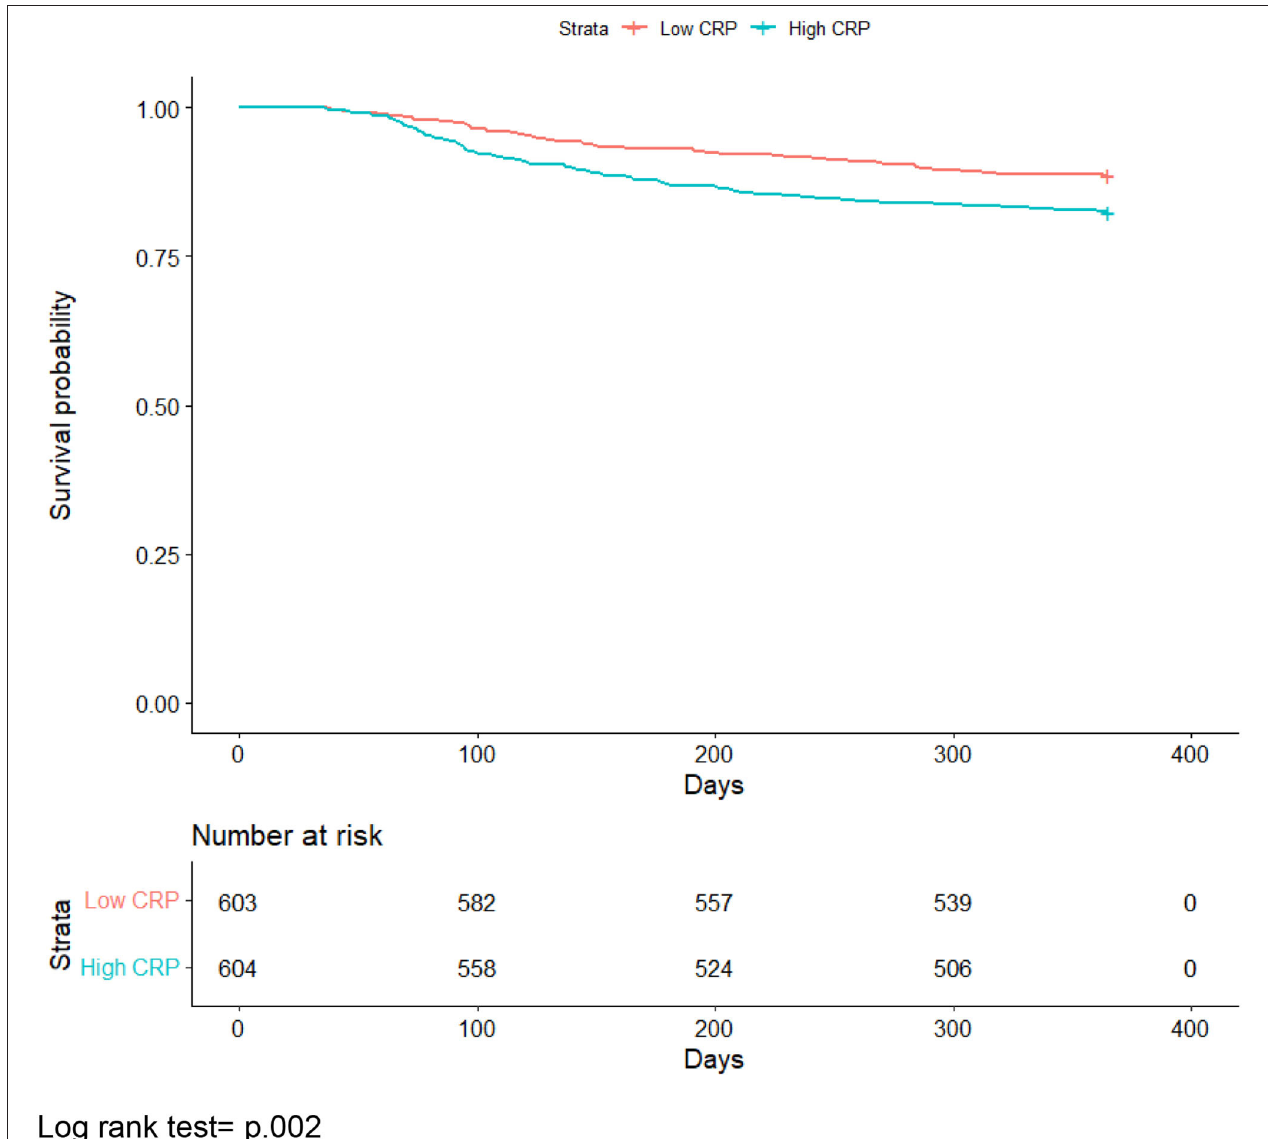
FIGURE 1 | All-cause mortality Kaplan-Meier curve comparing individuals with median or greater vs. below median C-reactive protein levels. Log rank test =